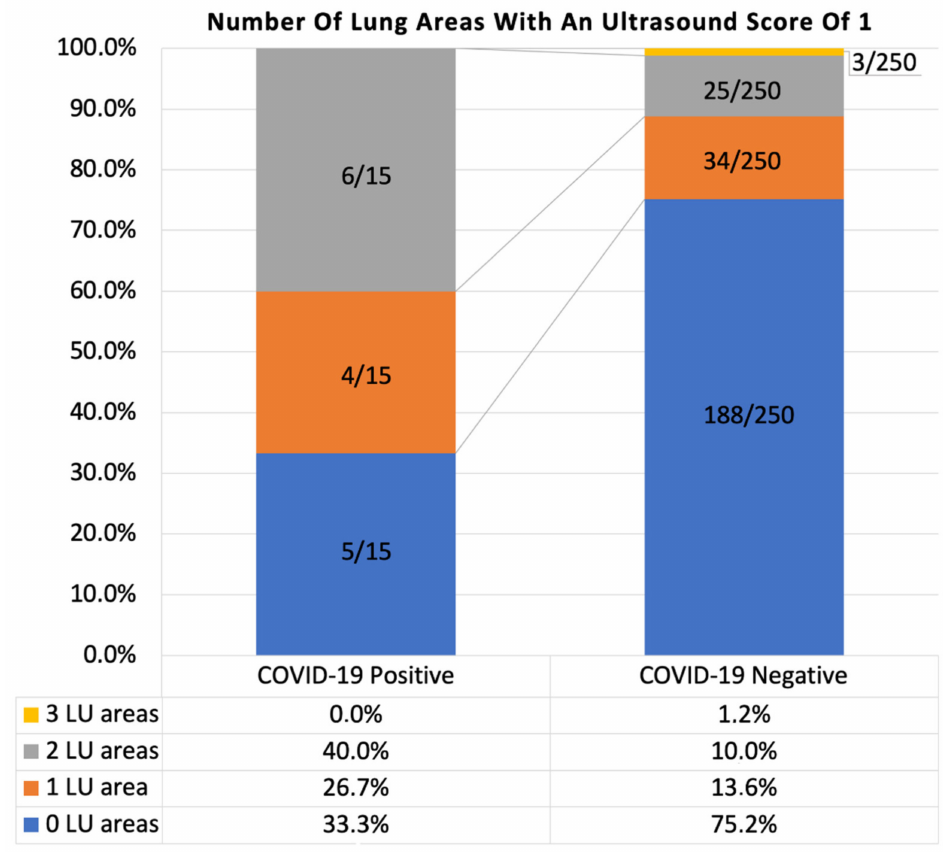
Figure 4. Number of lung ultrasound areas interested by an alteration scored as 1 (thickened, irregular pleural line, or small subpleural consolidations < 10 mm) in COVID-19 positive and negative groups. LU = lung